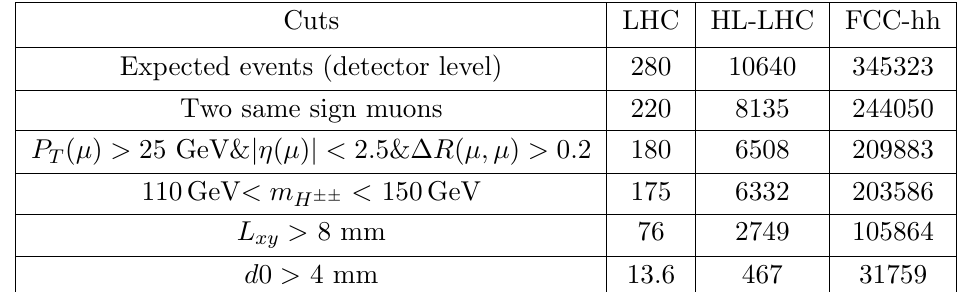
Table 1 . Cut (cid:13)ow of simulated signal samples for displaced decays of the H (cid:6)(cid:6) to same sign dimuons. For this table, the benchmark point with v T = 5 considered. For the LHC, HL-LHC, and FCC-hh we use 13, 14, and 100 TeV center-of-mass energy and an integrated luminosity of 100 fb (cid:0) 1 , 3000 fb (cid:0) 1 , and 20 ab (cid:0) 1 , respectively. In our analysis we consider the production channel pp simulation and normalization factors (cross section